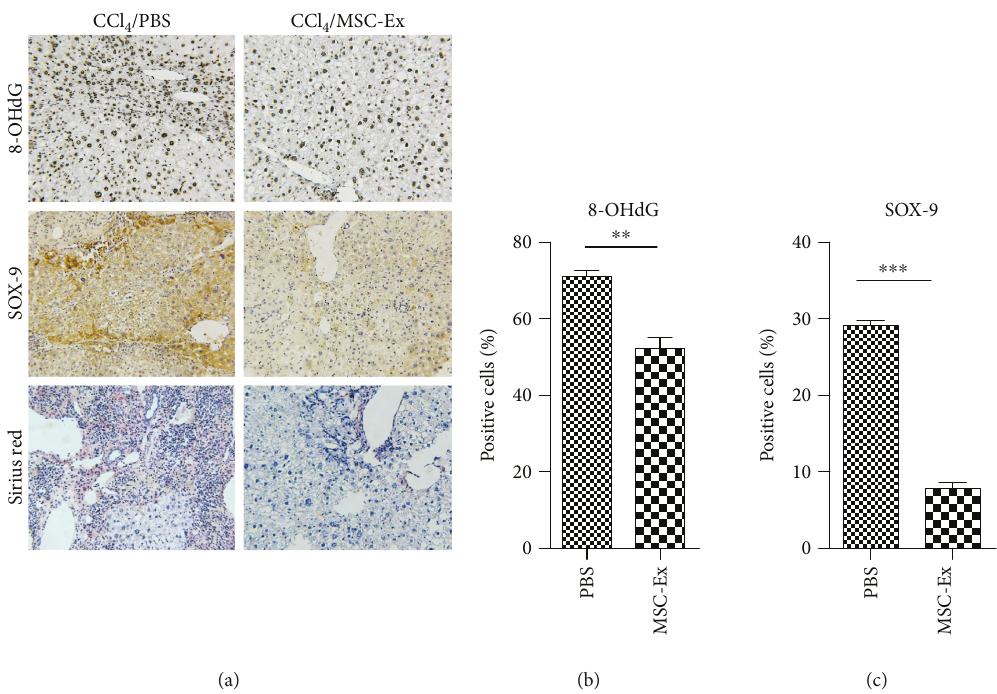
Figure 2: hucMSC-Ex reduced oxidative stress in mouse liver tumor. (a, b) The levels of 8-OHdG, SOX9, and collagen in mouse livers were measured by immunohistochemistry or Sirius red staining in liver tumor treated with PBS or hucMSC-Ex. Original magni fi cation 200x. Compared with the PBS group, hucMSC-Ex signi fi cantly reduced production of oxidative stress marker 8-OHdG, SOX9 expression, and collagen deposition in liver tumor ( n = 6 ; ∗∗ P < 0 01 , ∗∗∗ P < 0 001